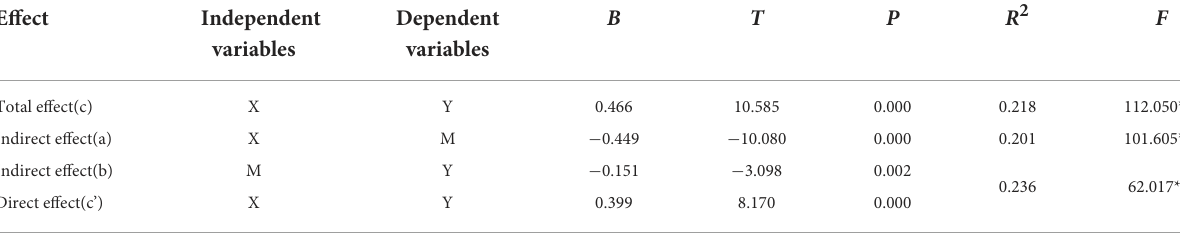
TABLE 2 Summary of the mediating effects of workplace violence between empathy and professional